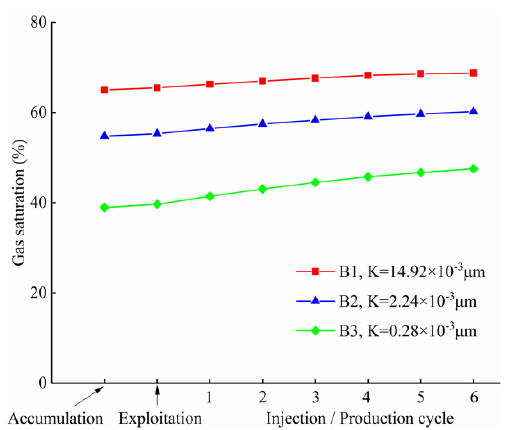
Figure 5. Variation curve of gas saturation in the pre-UGS gas zone.